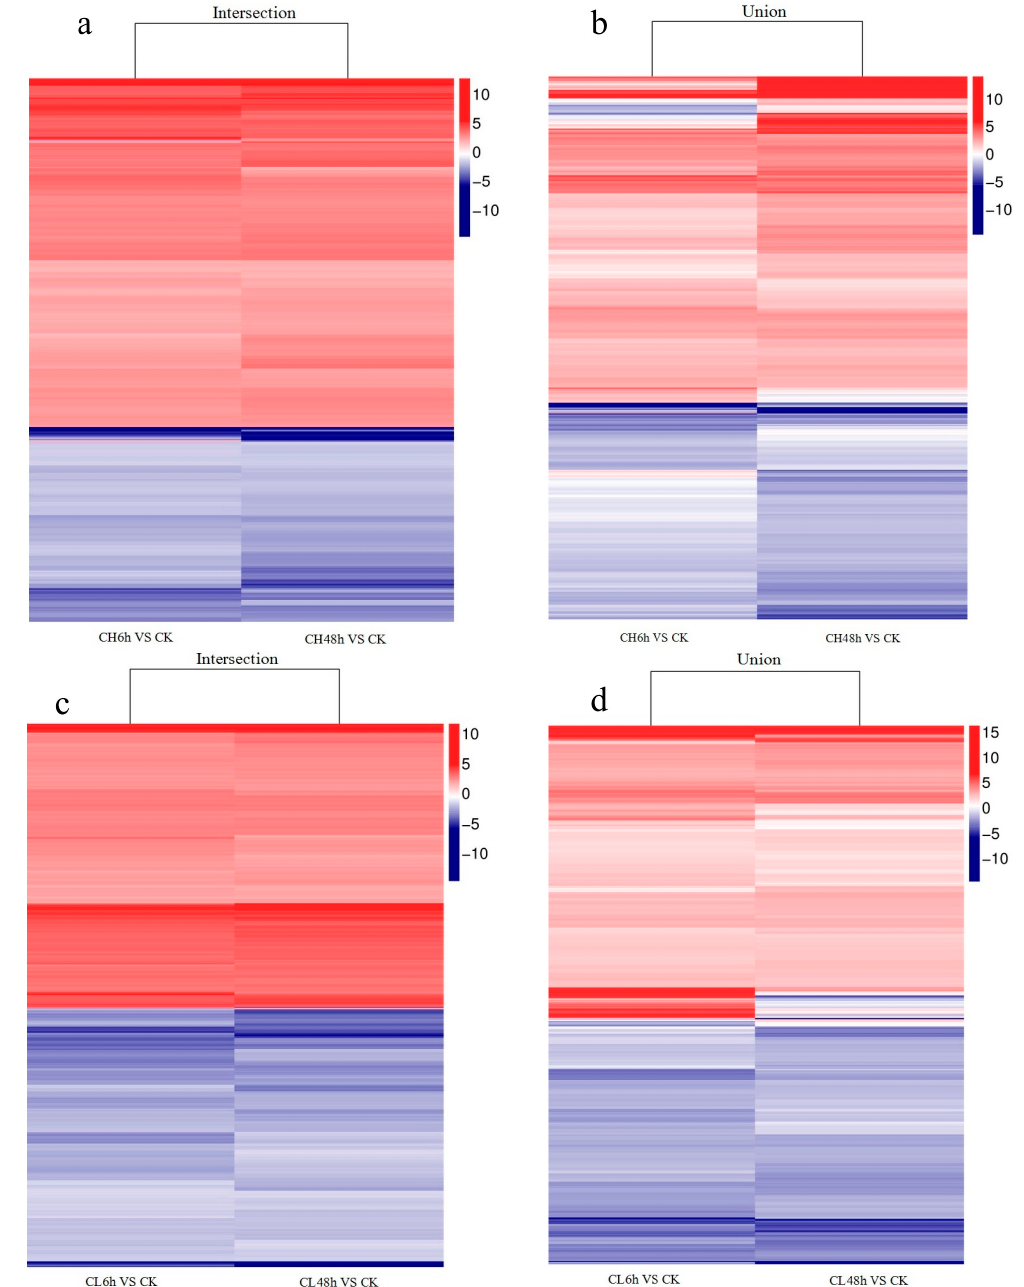
Figure 2. Heat map with dendogram for the Differential Expression Unigenes (DEUs) after treating the larvae with the same insecticide for different time durations. Gradient color barcode at the right indicates fold change of gene expression. CK: Control; CH: Chlorpyrifos; CL: Clothianidin; 6 h and 48 h: treatment with Chlorpyrifos or Clothianidin after 6 or 48 h. ( a , b ): DEUs for chlorpyrifos treated for 6 and 48 h in comparison with control, ( a ) is intersection and ( b ) is union; ( c , d ): DEUs for clothianidin treated for 6 and 48 h in comparison with control, ( c ) is intersection and ( d ) is union.